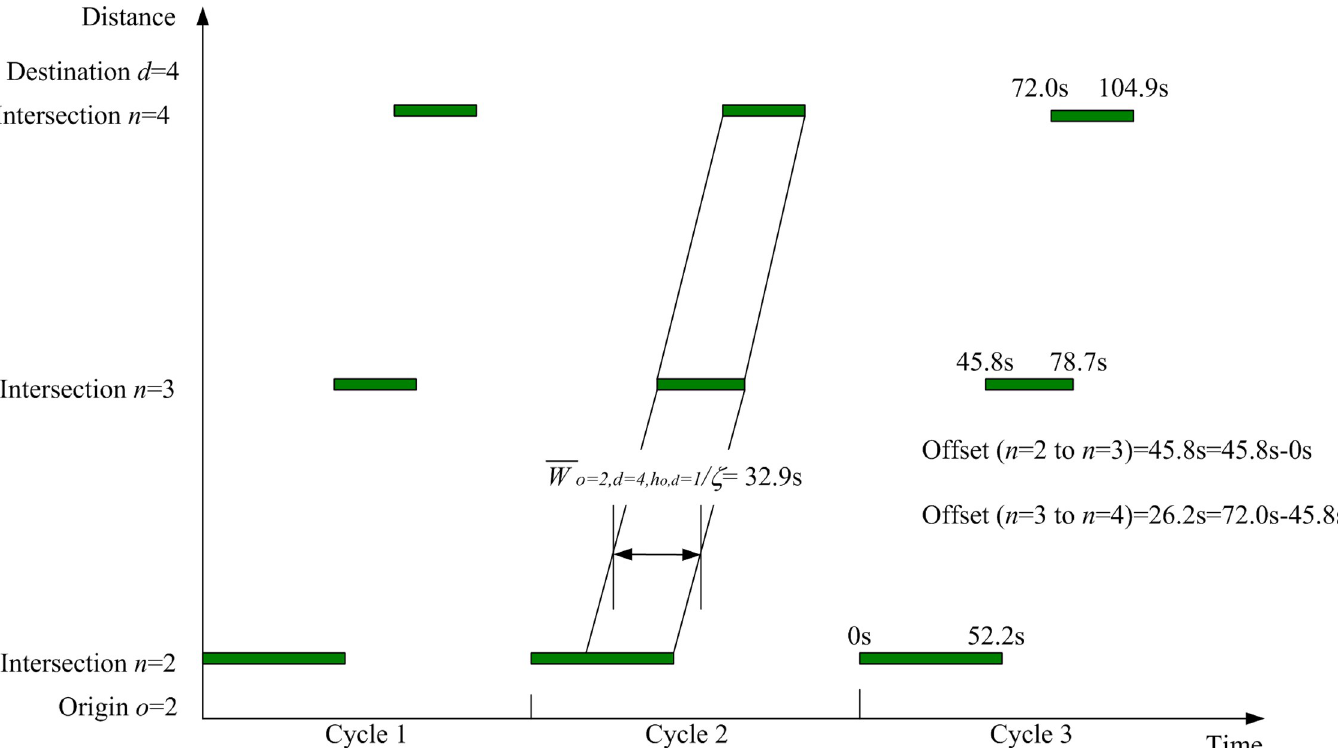
Fig 9. Time-space diagram from origin o = 2 at intersection n = 2 to destination d = 4 at intersection n = 4.